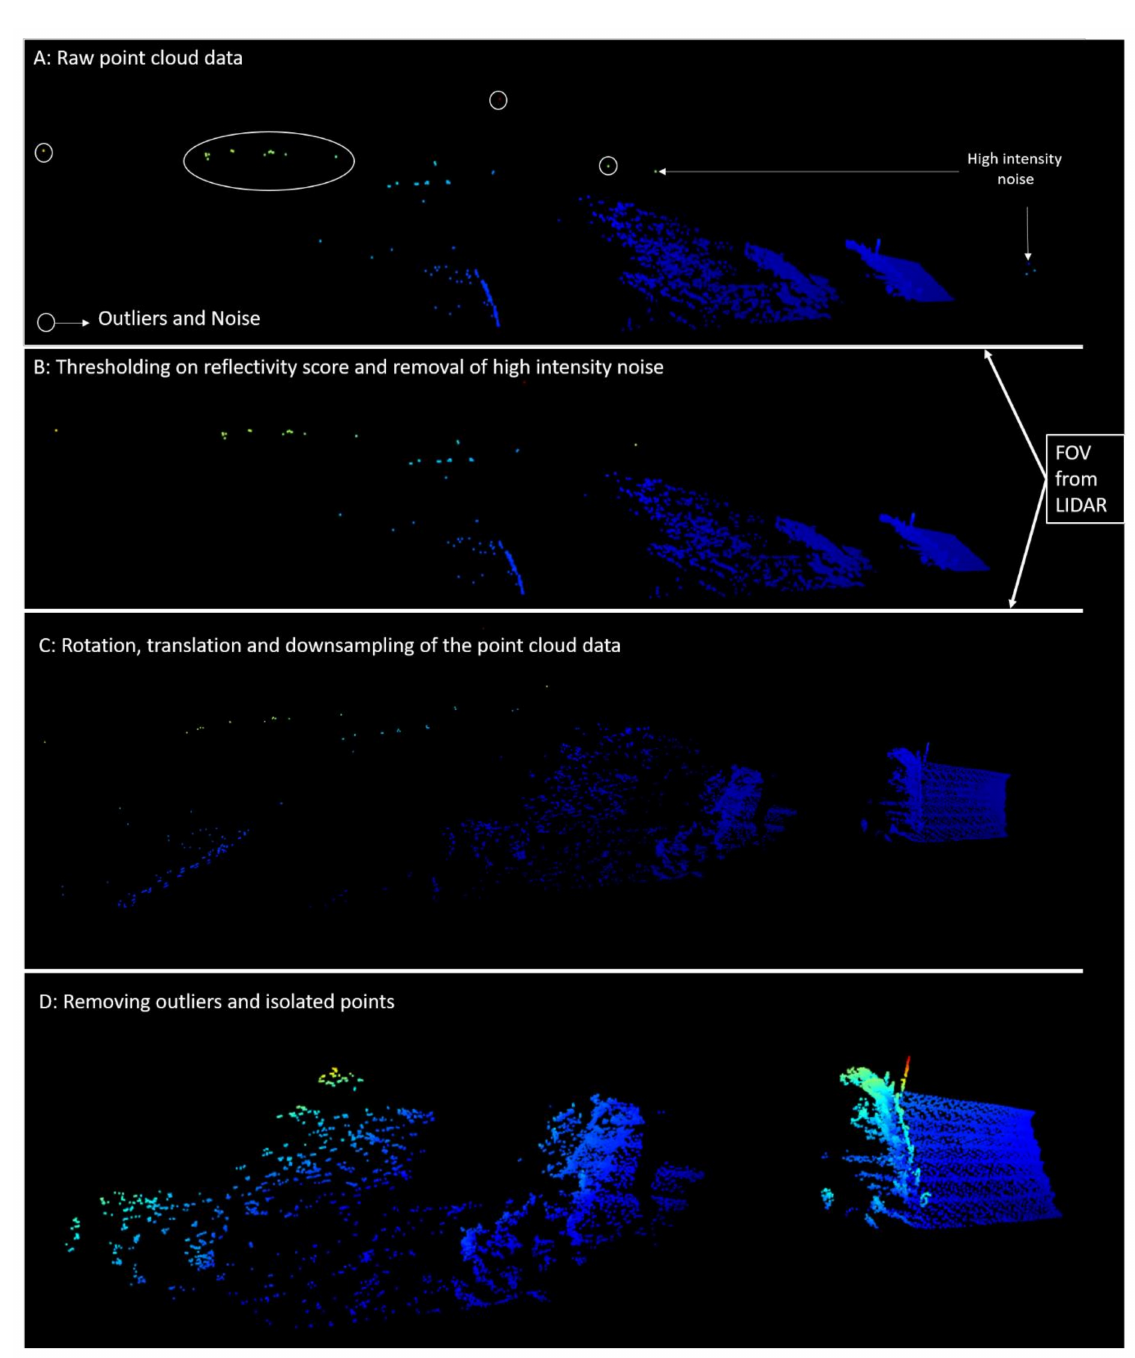
Figure 6. ( A ) Raw point cloud data acquired from the LiDAR; ( B ) Removal of high-intensity noise via thresholding on reflectivity values; ( C ) Output of rotation, translation and down-sampling of the point cloud data; ( D ) Removing outliers and isolated points from resultant point cloud